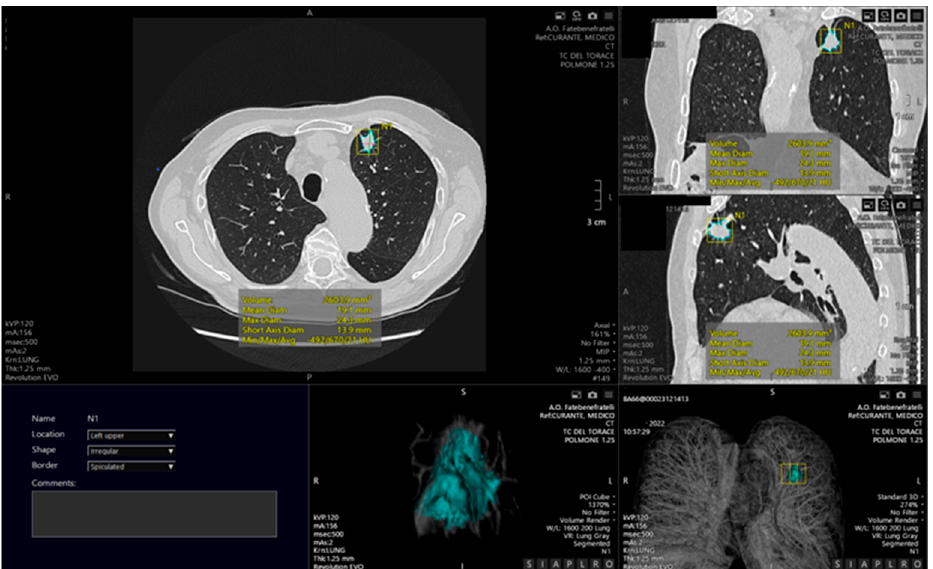
Figure 2. Example of automated segmentation of a pulmonary lesion located in the upper lower lobe, with automated calculation of the lesion volume, visible also as a 3D reconstruction.